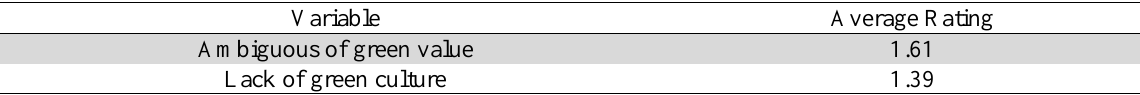
Friedman test based on cultural barriers